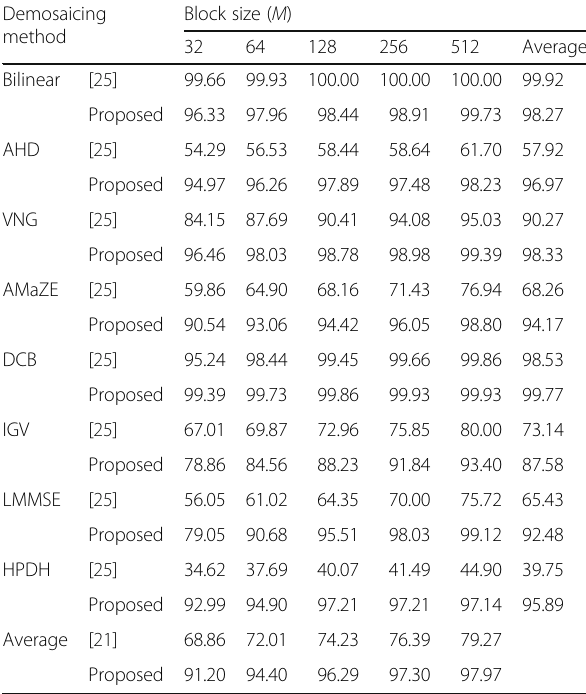
Table 5 Estimation accuracy comparison between existing algorithm and proposed method for various demosaicing methods (unit: %) Demosaicing